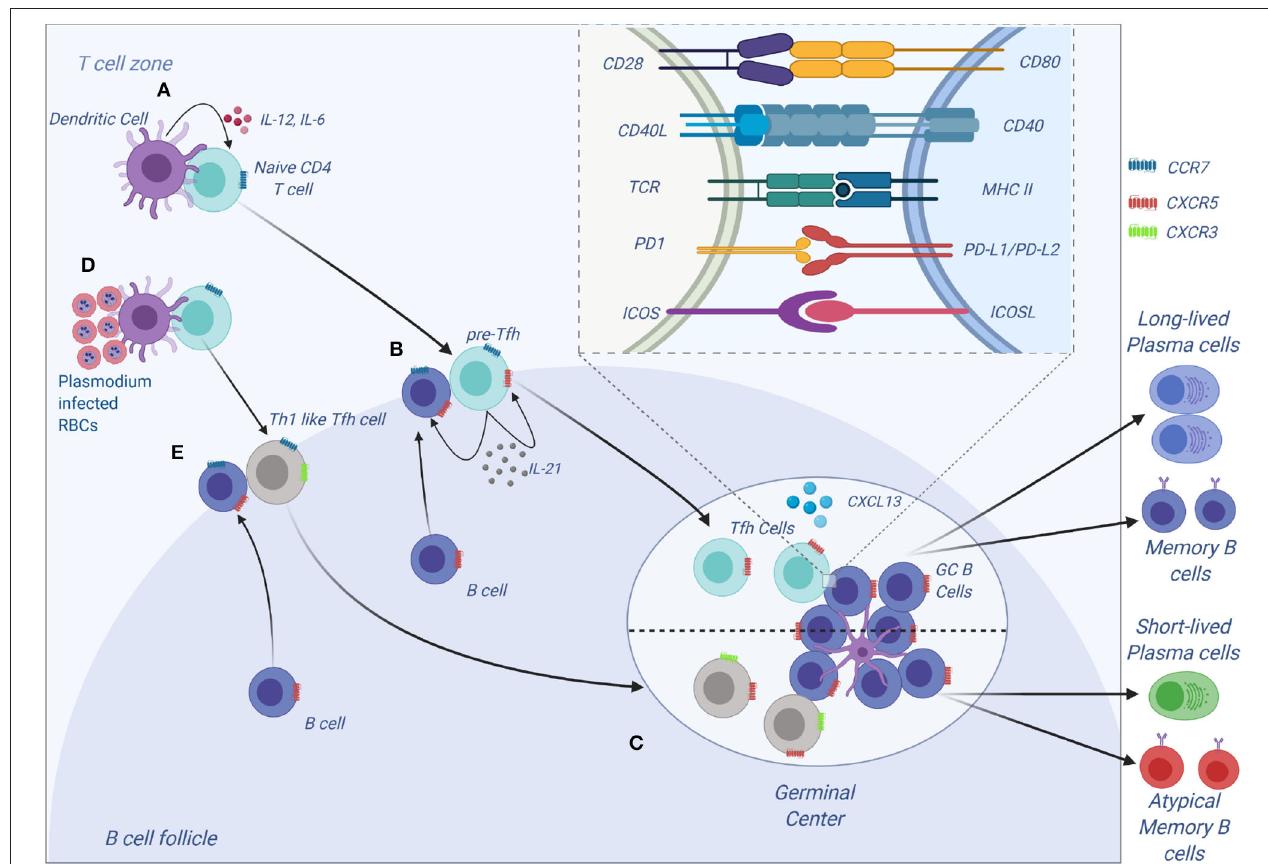
FIGURE 3 | Tfh development and function. (A) Tfh differentiation begins when an activated DC primes a naïve CD4T cells. Interaction between ICOS on CD4 and ICOS-L on DCs results in upregulation of Bcl-6 and CXCR5 on CD4T cells. IL-12 and IL-6, help maintain expression of Bcl-6, and IL-12 induces upregulation of IL-21 which is essential for survival of the pre-Tfh cell. Initial CD4T cell activation also results in upregulation of PD-1. The Bcl-6 + CXCR5 + PD-1 + pre–Tfh cell then migrates to the T cell–B cell border. At the same time, antigen-activated B cells upregulate CCR7 and migrates from the B cell follicle to the T cell–B cell border. (B) At the T cell–B cell border, the pre-Tfh cell engages with the B cell. Interaction between antigen-MHC on B cells with TCR on pre-Tfh, and ICOSL (B cell) with ICOS (pre-Tfh cell), fully commits the cell to Tfh lineage. This results in upregulation and maintenance of Bcl-6, SAP, and CXCR5, while downregulating CCR7 on T cells. (C) The Tfh and B cells move deeper into the B cell follicle forming GCs. Tfh cells in the GCs promotes B-cell maturation, class switching and affinity maturation via the cytokines, IL-21 and IL-4, and the molecules, CD40L and PD-1. Both Tfh and GC B-cell are necessary for generation of B-cell memory and long-lived plasma cells. (D,E) Plasmodium -induces polarization of T follicular helper (Tfh) cells to Th1 like phenotytpe that expresses Tbet PD-1, CXCR5, CXCR3 and contributes to the inefficient acquisition of humoral immunity to malaria. Malaria infection in mice and humans induces secretion of Th1-polarizing cytokine that drive the activation of Th1-like Tfh cells that exhibit impaired B cell helper function, thus contributing to germinal center dysfunction and suboptimal antibody responses (Figure was created using